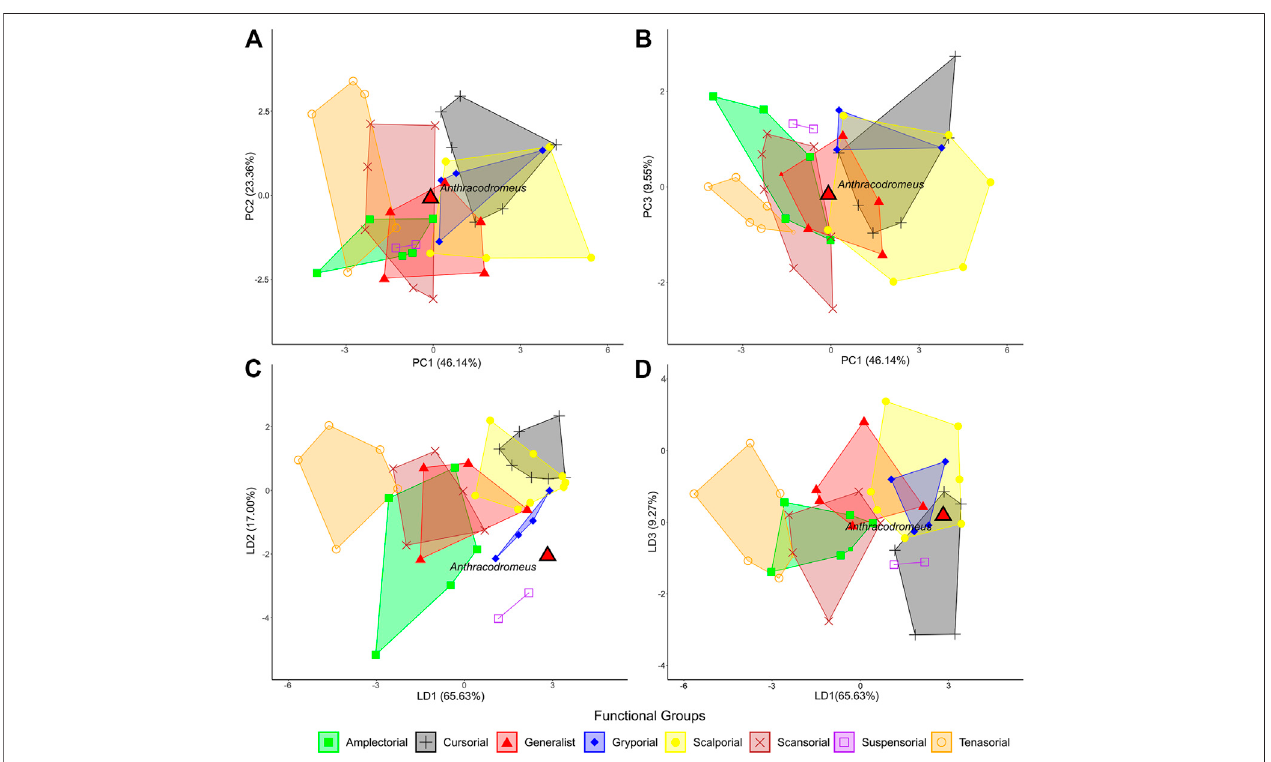
FIGURE5| Comparisonofclawshapein Anthracodromeus tothoseoftheextantamniotesfromthompsonandmotani(2021).VisualizationsofthemainPCaxes: (A) PC1 vs. PC2 (69.50% of the variation); (B) PC1 vs. PC3 (55.69% of the variation); and the main LD axes: (C) LD1 vs. LD2 (82.63% of the variation); (D) LD1 vs. LD3 (74.90% of the